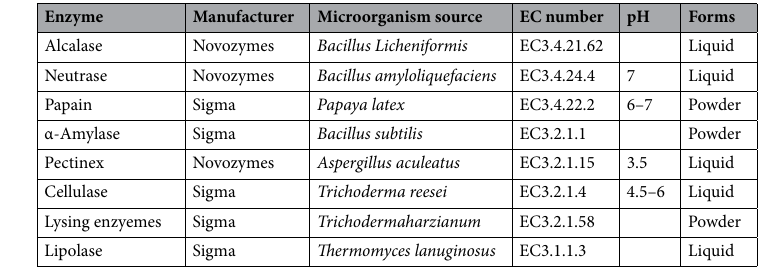
Table 2. Tested enzymes and their respective